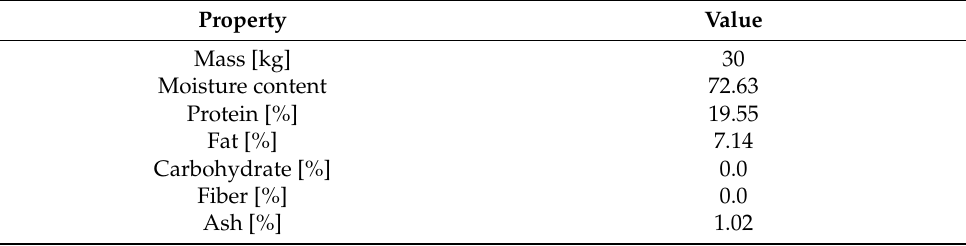
Table 2. Meat-agent